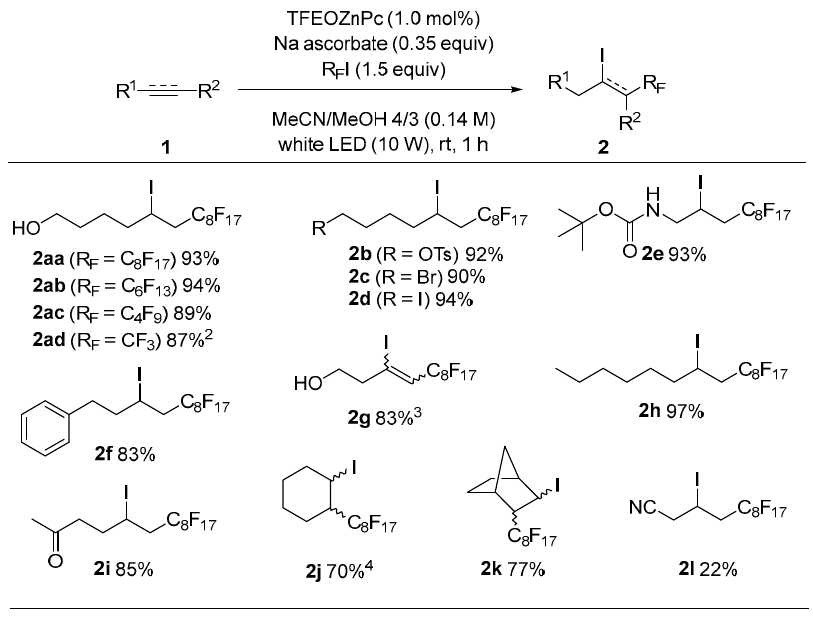
Figure 1. Perfluoroalkylation reaction of 1 with TFEO-ZnPc under visible light irradiation. The reaction of 1 (0.25 mmol) with perfluoroalkyliodide (0.375 mmol) was carried out in the presence of TFEO-ZnPc (0.0025 mmol) and Na ascorbate (0.0875 mmol) in MeCN (1.0 mL) and MeOH (0.75 mL) at room temperature under irradiation with white LED (10 W). Yields are shown as isolated yield. 2ad : The reaction was carried out for 5 h with an excess amount of CF 3 I. 2g : 3.7:1 dr. 2j : 1.8:1 dr. R F I: perfluoroalkyliodide.